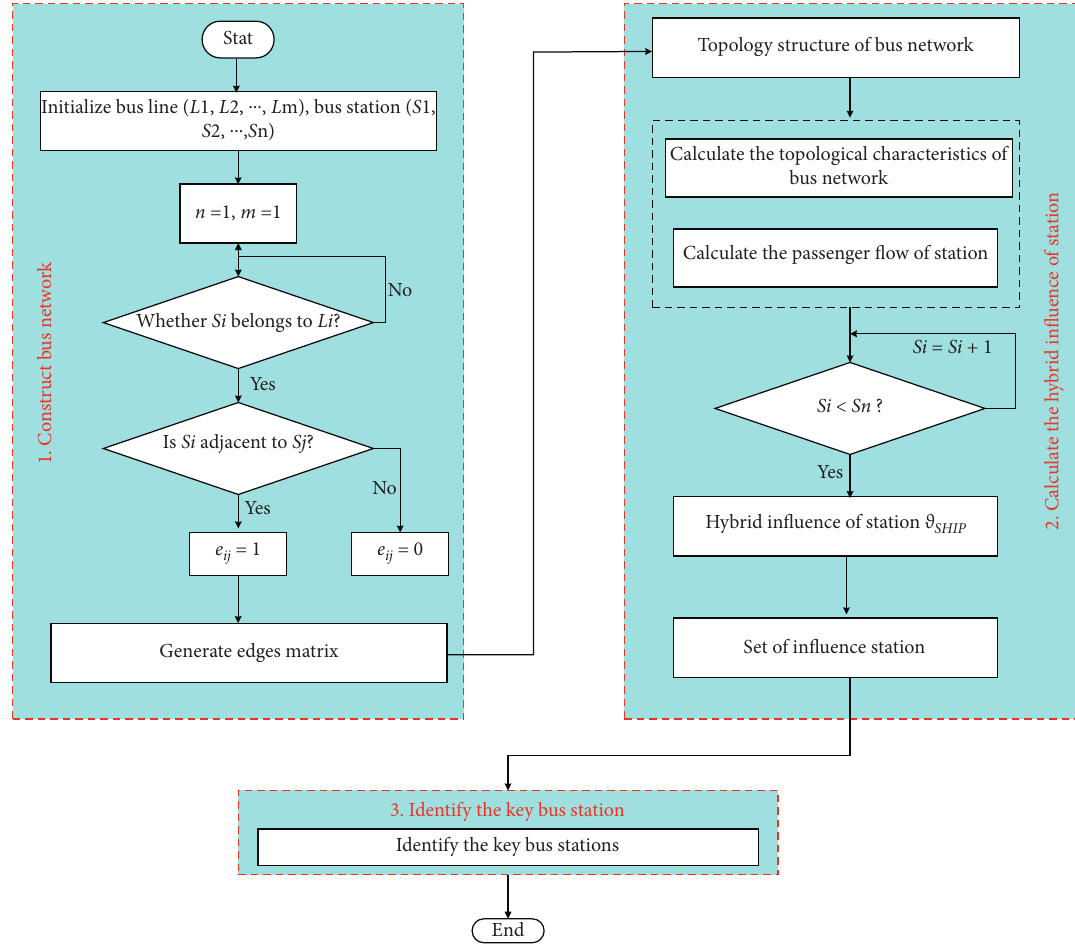
Figure 5: The flowchart of the solution